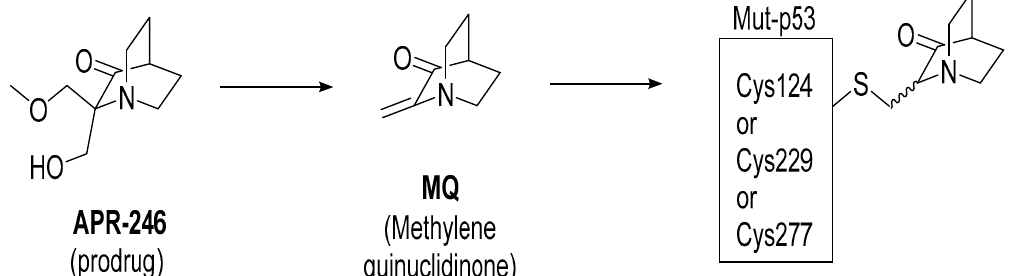
Figure 13. APR-246 forms MQ, which is a reactive Michael acceptor, which undergoes covalent addition with mutant p53 residues Cys124, Cys229, and Cys277, which are the most exposed and reactive residues.